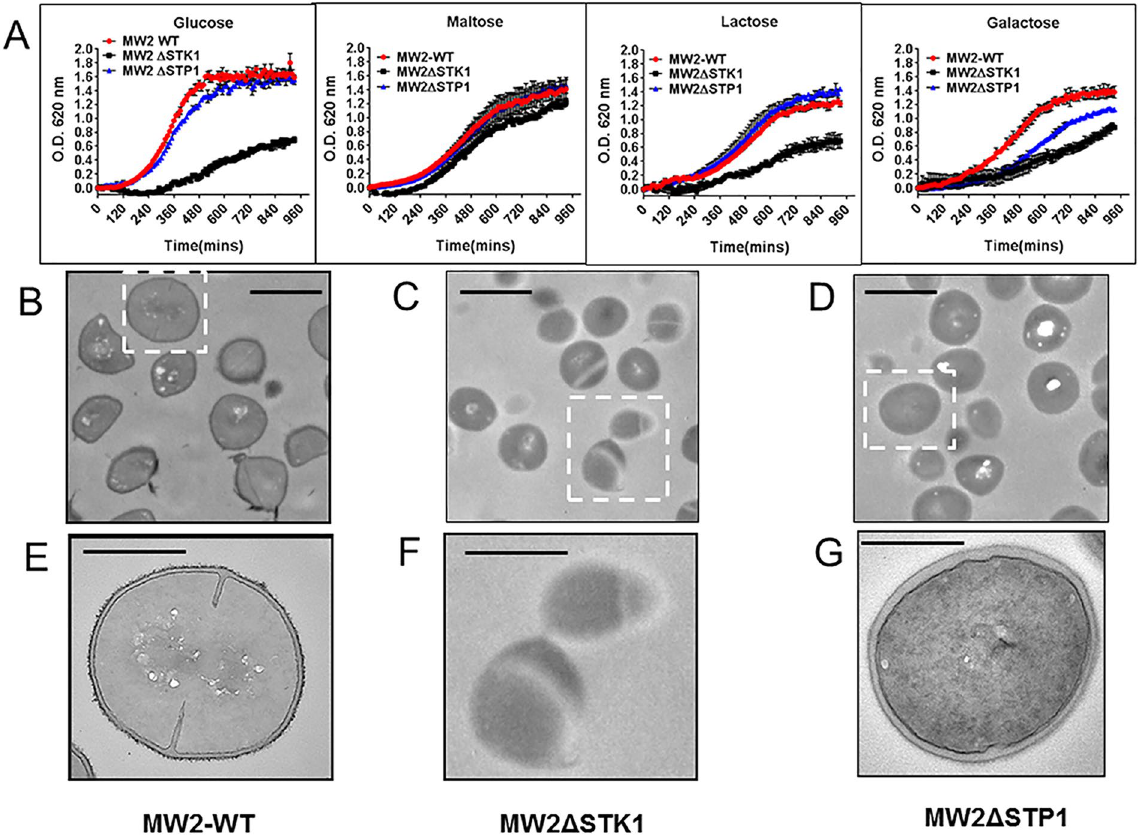
Figure 1. The impact of the deletion of stk1 and stp1 genes in S . aureus MW2 growth and cell wall structure. ( A ) Growth patterns of the S . aureus MW2-wild-type, MW2 Δ STK1, and MW2 Δ STP1 strains in Chemically defined medium (CDM) supplemented with 1% carbohydrate (glucose, maltose, lactose, or galactose). Growth kinetics were measured in 96-well plates at 37 °C for 16 hours under constant rotation in a final volume of 200 µ l using sterile 96-well plates. Optical density at 620 nm was measured at every 15 min. Data at each time point represent an O.D. value (mean ± SD) obtained from three different experiments and each with quadruple wells for each strain. O.D. was measured spectrophotometrically as described in the Materials and Methods. Growth curves are shown in Red – MW2-wild-type strain; Black – MW2 Δ STK1 mutant; Blue – MW2 Δ STP1 mutant strains. ( B – D ) Transmission electron microscopy (TEM) at a low resolution of ( B ) wild-type MW2 and corresponding isogenic ( C ) Δ STK1 and ( D ) Δ STP1 mutants. The wild-type and mutant strains were grown in TSB, fixed in the glutaraldehyde and paraformaldehyde fixative and subsequently subjected to transmission electron microscopy as described in Materials and Methods. Inset bar-1.0 µ m. ( E – G ) TEM of ( B – D ) at a higher resolution. Inset bar-500